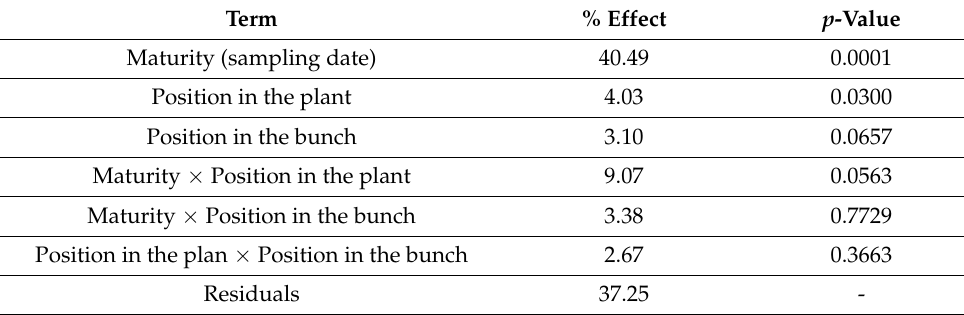
Table 5. Main effects and their combinations for the ASCA